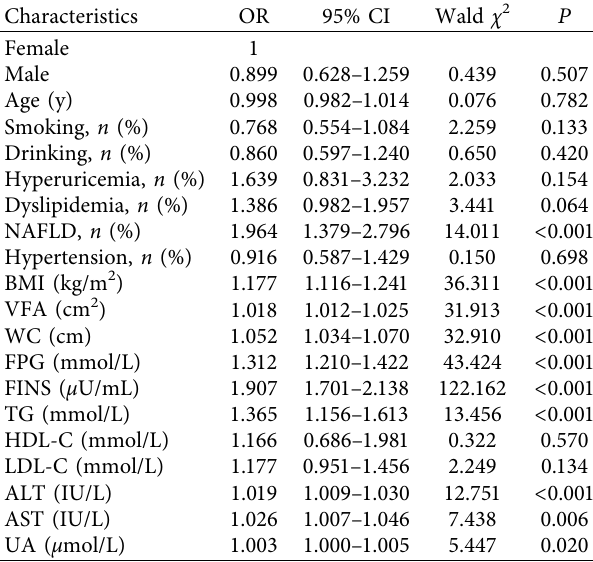
Table 3: Multivariate logistic regression analysis of factors affecting